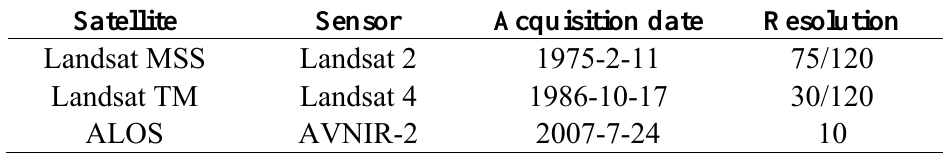
Table 1. Key characteristics of satellite data used for land use/cover change